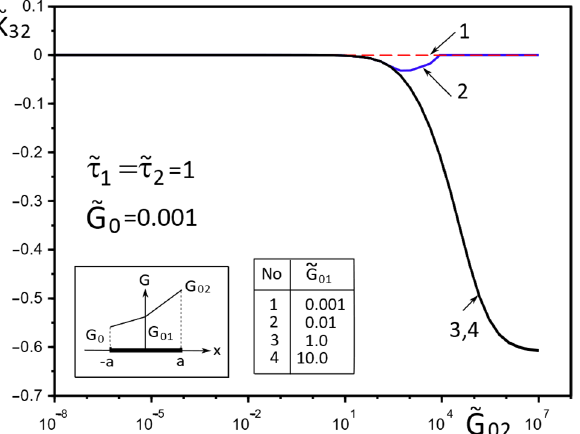
Figure 2. Influence of the parameters (cid:101) G 0 , (cid:101) G 01 , (cid:101) G 02 on the GSIF (cid:101) K + distributed on infinity stress σ ∞ yz = τ .